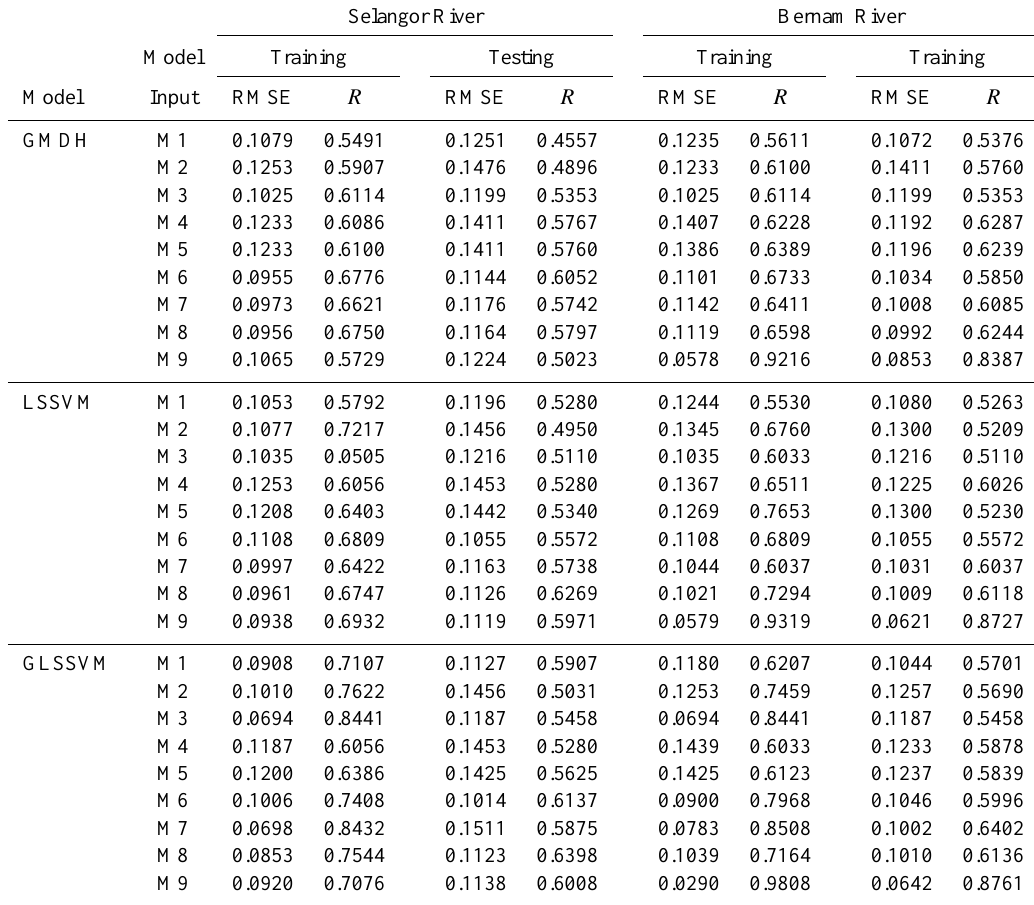
Table 5. The RMSE and R statistics of GMDH, LSSVM and GLSSVM Models for Selangor and Bernam